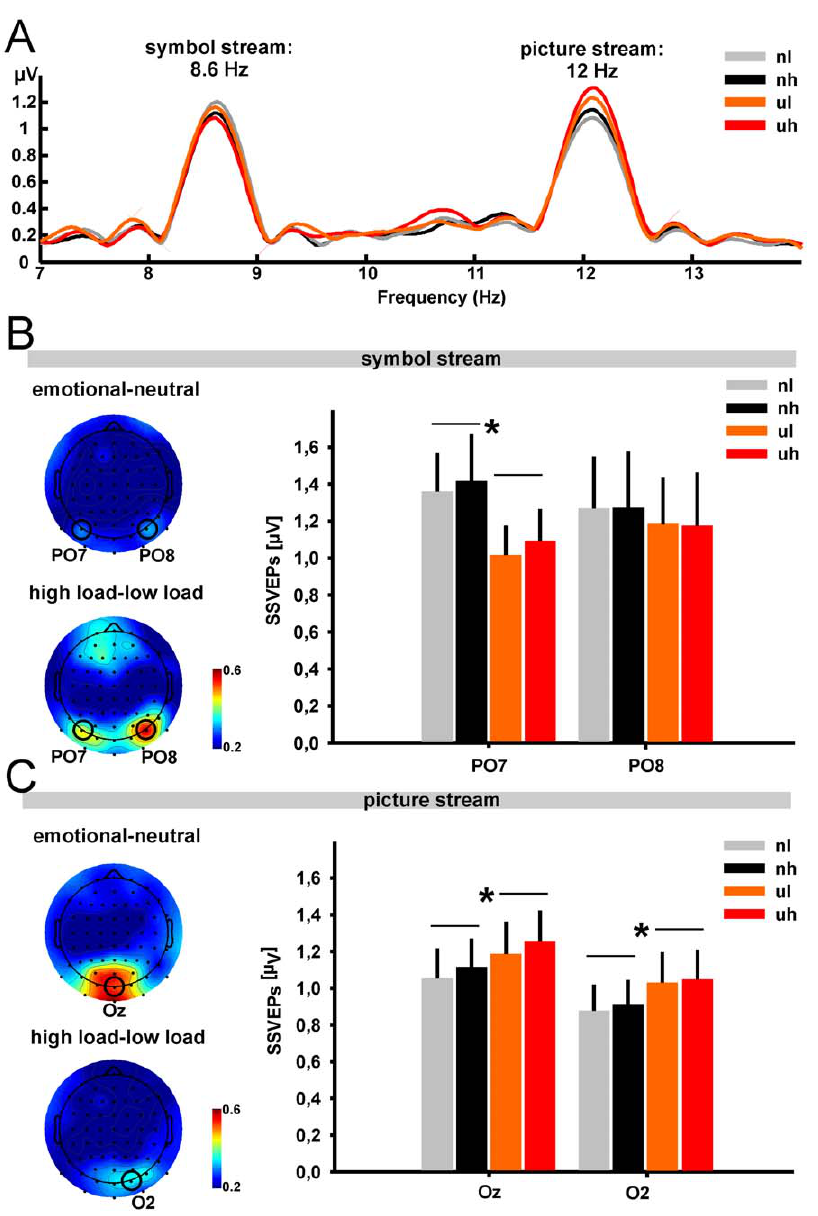
Figure 3. SSVEP amplitudes and iso-contour voltage maps. (A) Grand-average spectrum obtained by Fourier analysis of SSVEP waveforms for all four experimental conditions, i.e. neutral pictures and low load (light grey line), neutral pictures and high load (black line), unpleasant pictures and low load (orange line) and unpleasant pictures and high load (red line) averaged across occipital electrodes (PO8, OZ, PO7). Peaks are located at the two stimulation frequencies at which the symbol stream and the picture stream were presented. (B) Iso-contour voltage maps based on the difference between the topographical distribution of emotional minus neutral SSVEP amplitudes (upper left panel) and high load minus low load SSVEP amplitudes (lower left panel) at the stimulation frequency of the symbol stream (8.6 Hz). The right panel shows the grand-average SSVEP amplitudes and corresponding standard errors for the symbol stream and each experimental condition for the two electrodes indicated in the iso- contour voltage maps (PO7, PO8). (C) Iso-contour voltage maps based on the difference between the topographical distribution of emotional minus neutral SSVEP amplitudes (upper left panel) and high load minus low load SSVEP amplitudes (lower left panel) at the stimulation frequency of the picture stream (8.6 Hz). The right panel shows the grand-average SSVEP amplitudes and corresponding standard errors for the picture stream and each experimental condition for the two electrodes indicated in the iso-contour voltage maps (OZ, O2). Abbreviations: nl=neutral low load; nh=neutral high load; ul=unpleasant low load; uh=unpleasant high